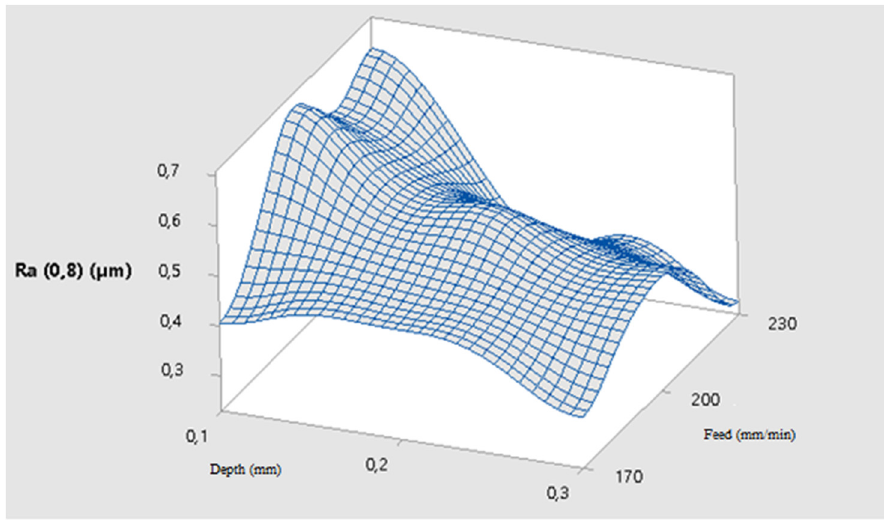
Figure 12: E ff ects of depth of cut and feed rate on surface